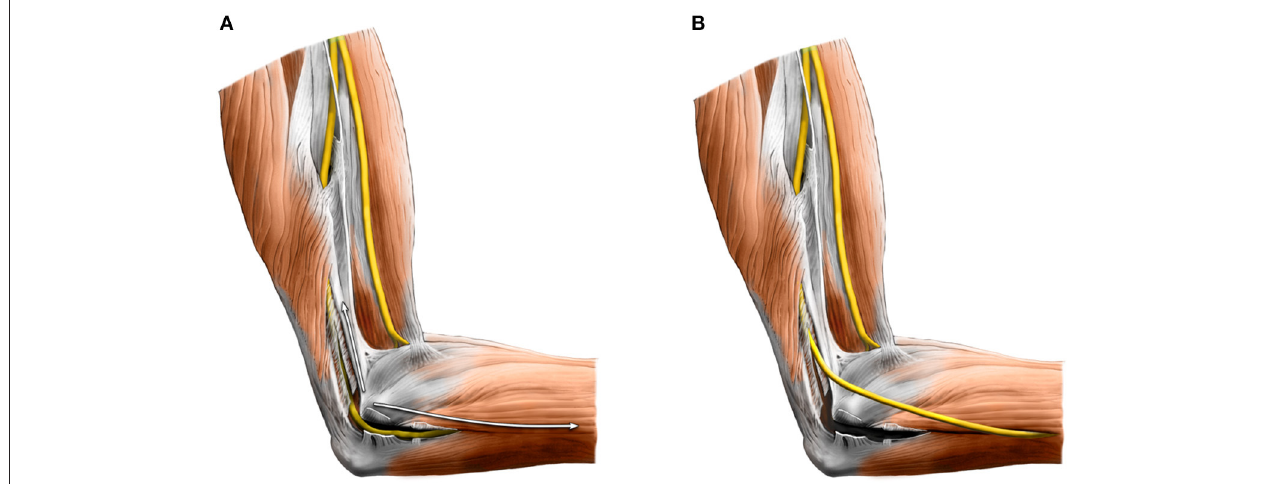
FIGURE 11 | (A) In situ decompression of the ulnar nerve in the cubital tunnel. (B) Anterior subcutaneous transposition—after wide decompression, the ulnar nerve is transposed anteriorly under the cutaneous